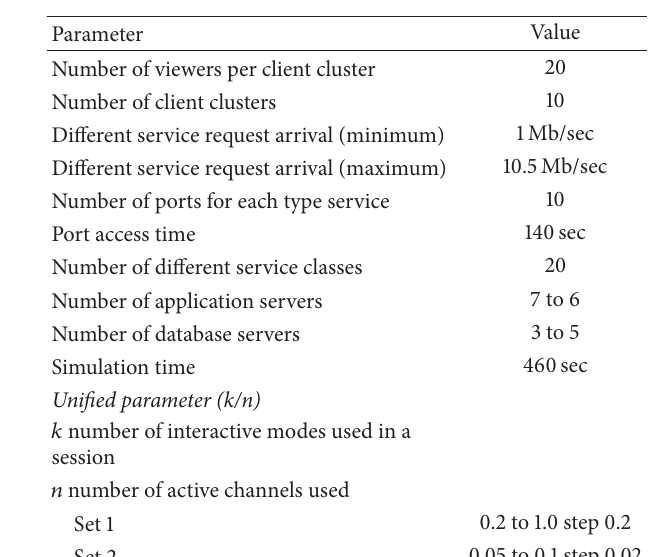
Table 1: Simulation